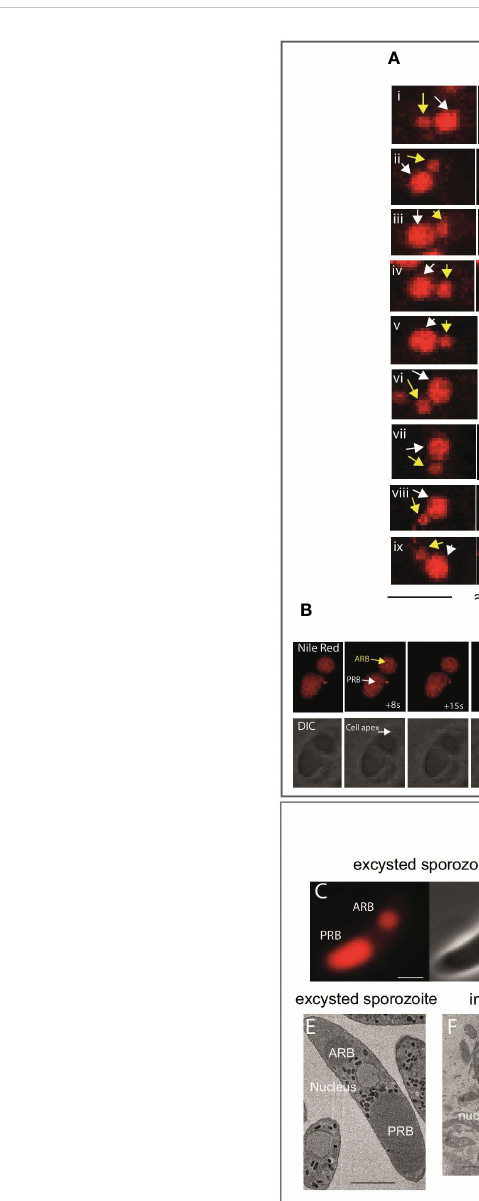
merger and containing an RBant. was 2.41 whereas mean length/width of sporozoites after merger and without an RBant. was 1.95 (p = 0.013, T-test) (Supplementary Figure 1). These data suggest that the extent of sporozoite rounding (greater roundness having length/width value closer to one) is associated with RB merger.